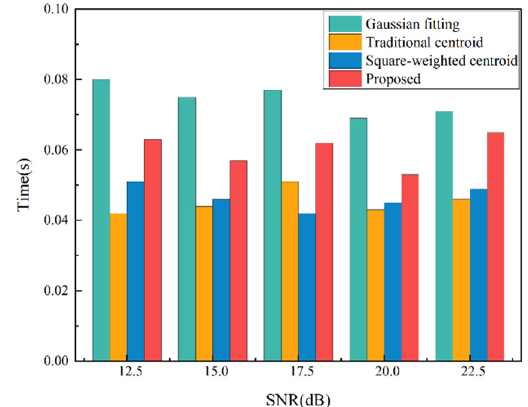
Figure 8. Iterative convergence process of spot area.